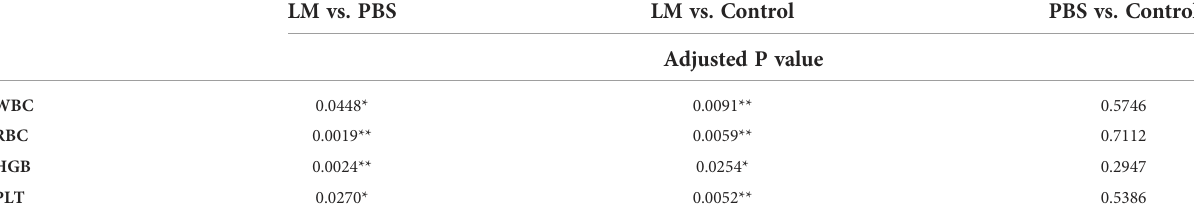
TABLE 6 The statistical results of post-hoc analysis in haematology tests. LM vs. PBS